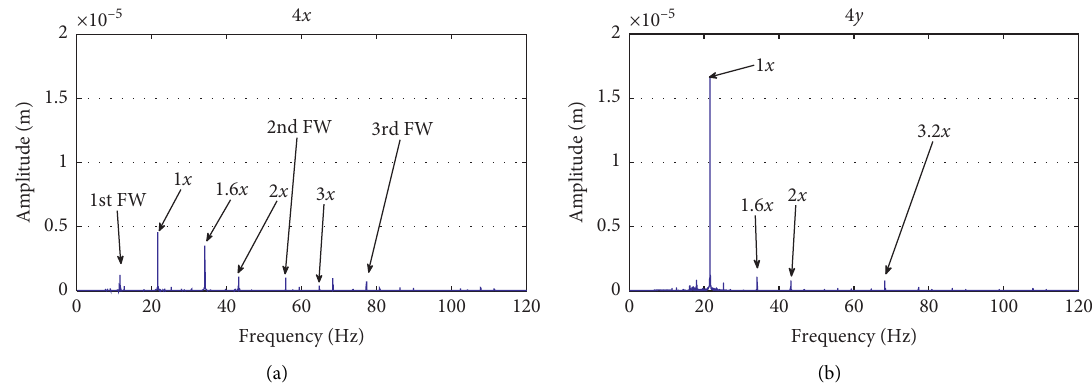
� 21Hz: (a) horizontal direction and (b) vertical direction. 1